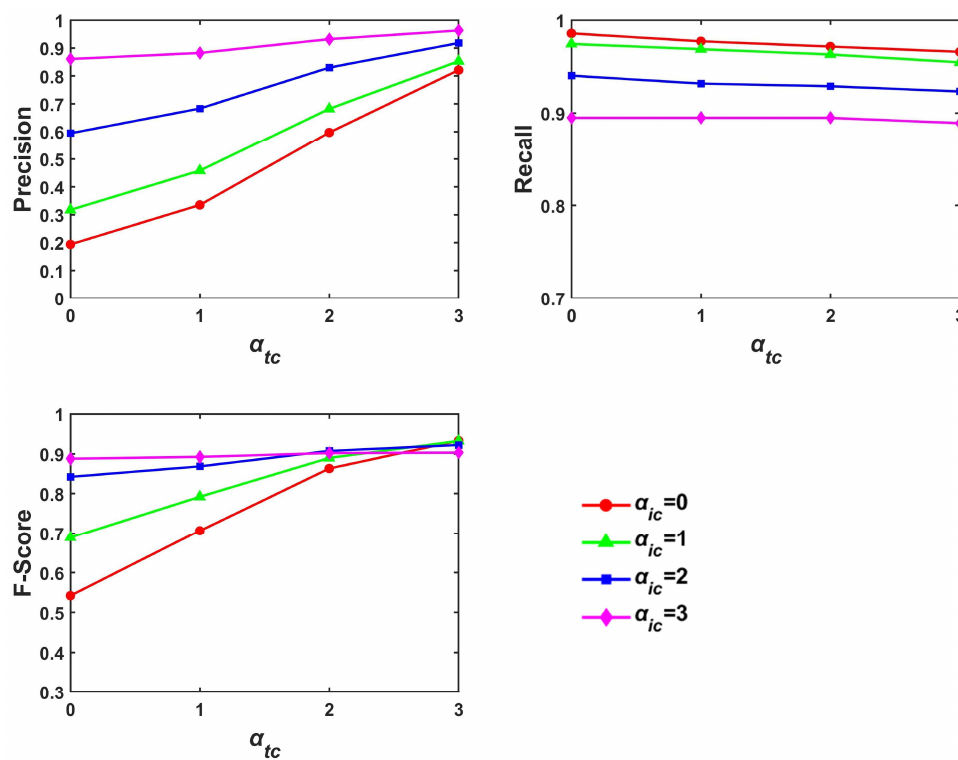
Figure 5. Leakage detection performance for the steady-state time series data set under different threshold coefficients.